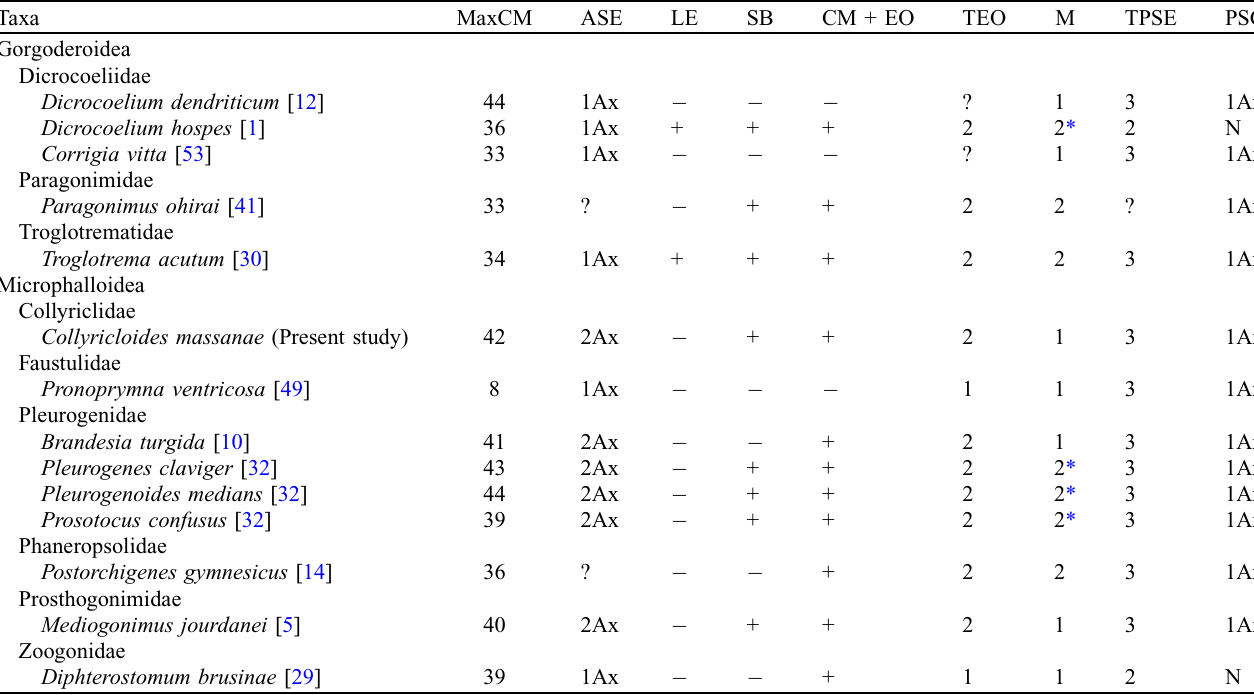
Table 1. Ultrastructural characteristics of the mature spermatozoon in the Gorgoderoidea and Microphalloidea.